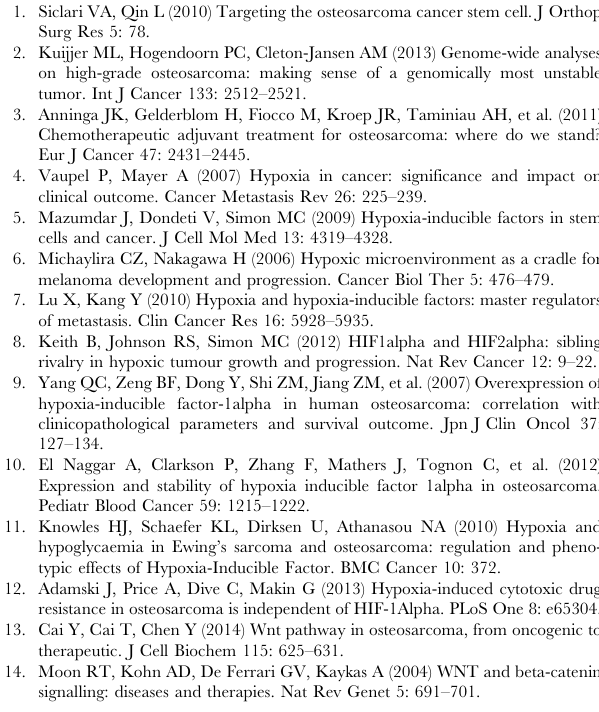
Figure S3 Effects of HIF knockdown on OS cell resis- tance to doxorubicin. 72 hour doxorubicin IC 50 values are shown for two independent shRNA’s targeting either HIF-1 a or HIF-2 a in MNNG/HOS cells. No significant difference was noted under hypoxic conditions (n = 3). (TIF) Figure S4 Validation of Wnt/ b -catenin Signaling Inhi- bition by XAV939 and IWP-2. MG-63 cells were treated with either 10 m M XAV939 or IWP-2, with DMSO serving as a control. Active b -catenin protein levels were decreased by both XAV939 and IWP-2 compared to DMSO, and XAV939 treatment resulted in decreased in total b -catenin levels as determined by western blot. Treatment with XAV939 and IWP- 2 also resulted in decreased mRNA expression of Wnt target genes axin2 and c-myc.